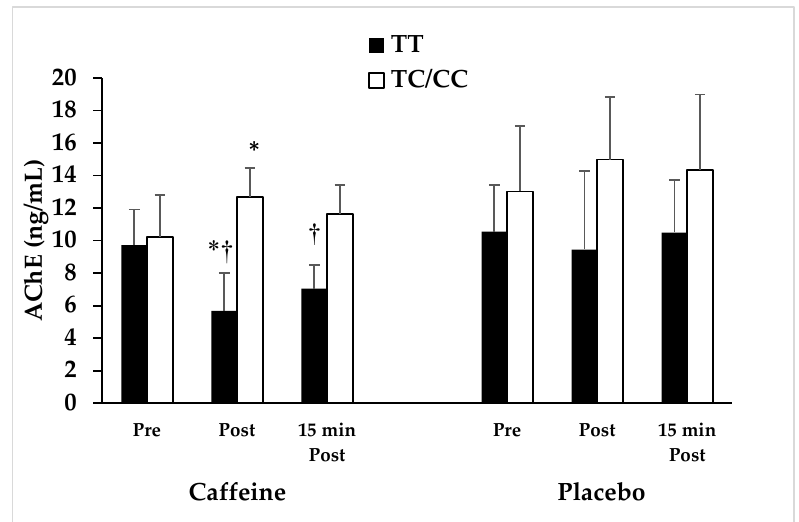
Figure 1. AChE response to resistance exercise in athletes with ADORA2A C allele and TT genotype following caffeine and placebo supplementation. * indicates significant difference vs. pre ( p = 0.043). † indicates significant differences between TT genotype and C allele carriers ( p = 0.013). AChE: acetylcholinesterase.